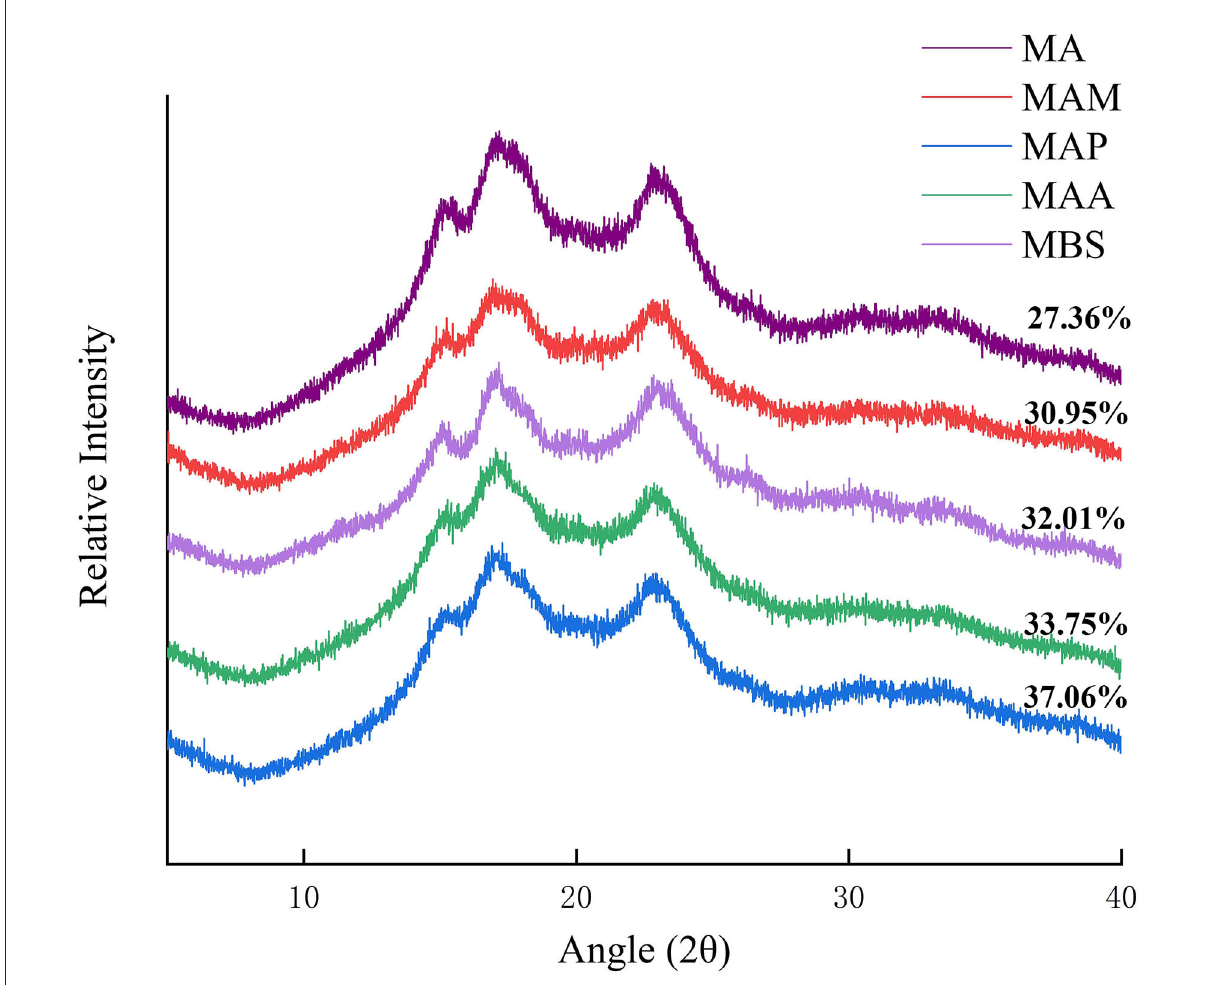
FIGURE1 X-ray diffraction patterns of starch